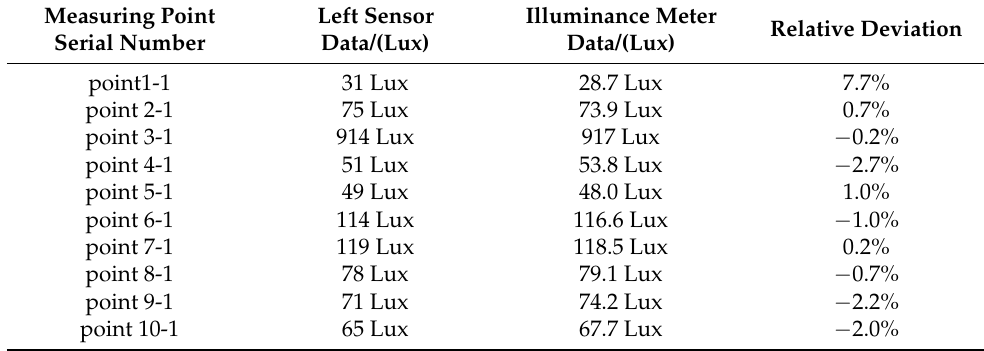
Table 1. Data comparison table of left illuminance sensor and illuminometer.